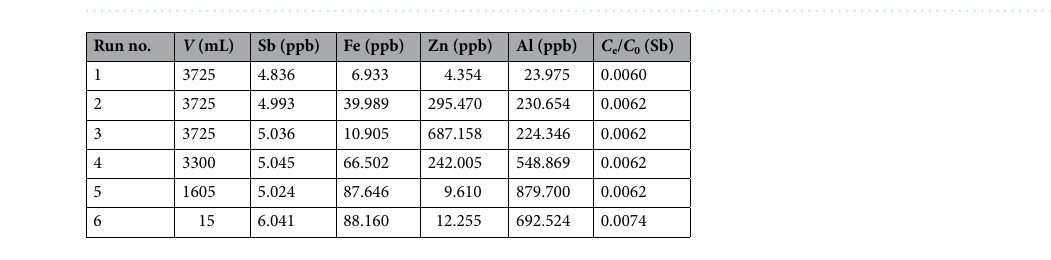
Table 1. Fe, Zn, Al, and Sb contents in effluents collected after multiple runs.